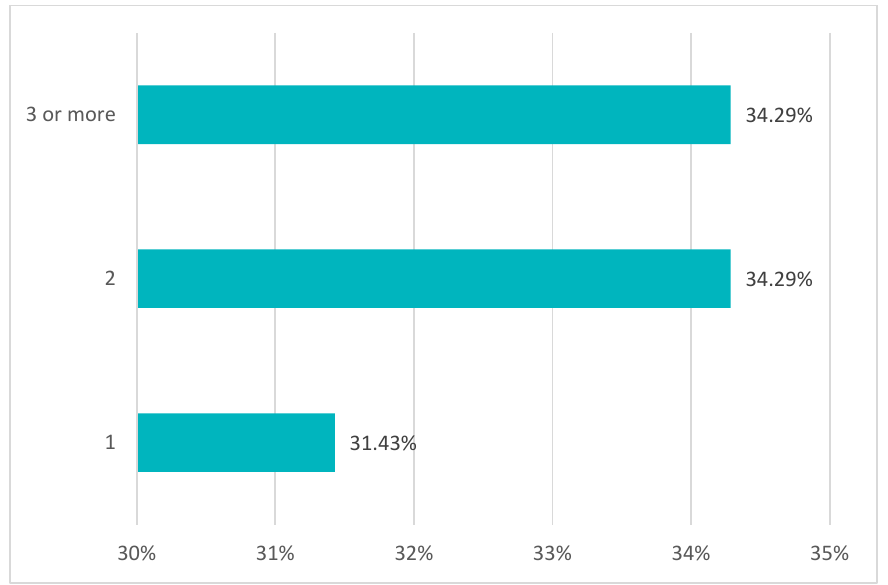
Figure 11. Number of vehicles owned by the household.